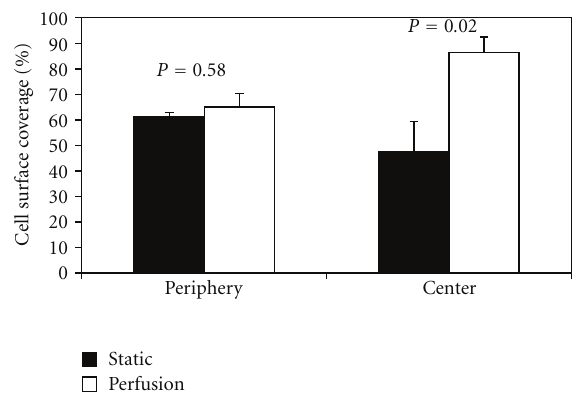
Figure 7: Surface coverage is increased in three-dimensional sca ff olds when exposed to perfusion flow for 14 days. Cell surface coverage was calculated as a % of the length of cell-covered sca ff old surface to the total length of sca ff old surface. Periphery is the mean value of the 8 peripheral regions.